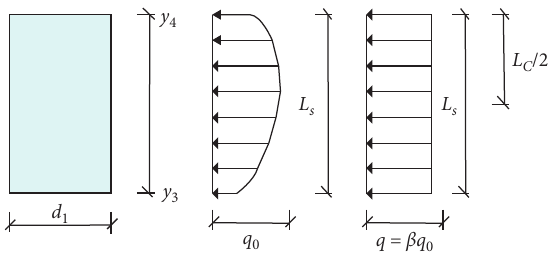
Figure 14: Calculation diagram of the stiffened angle